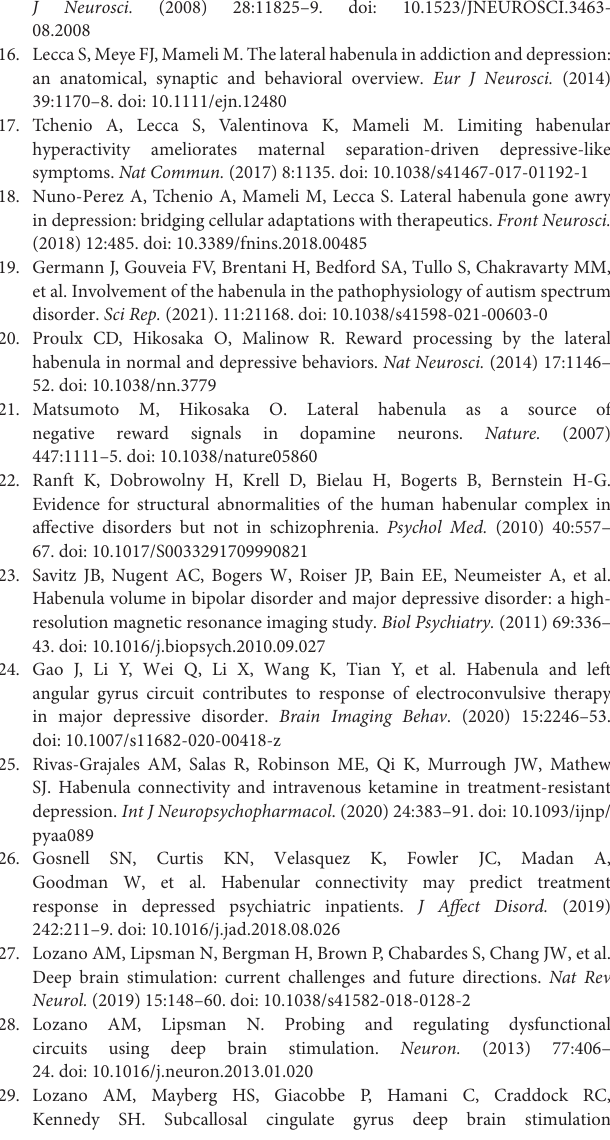
Supplementary Table 1 | Imaging acquisition parameters for structural MR imaging. Supplementary Table 2 | Imaging acquisition parameters for functional MR